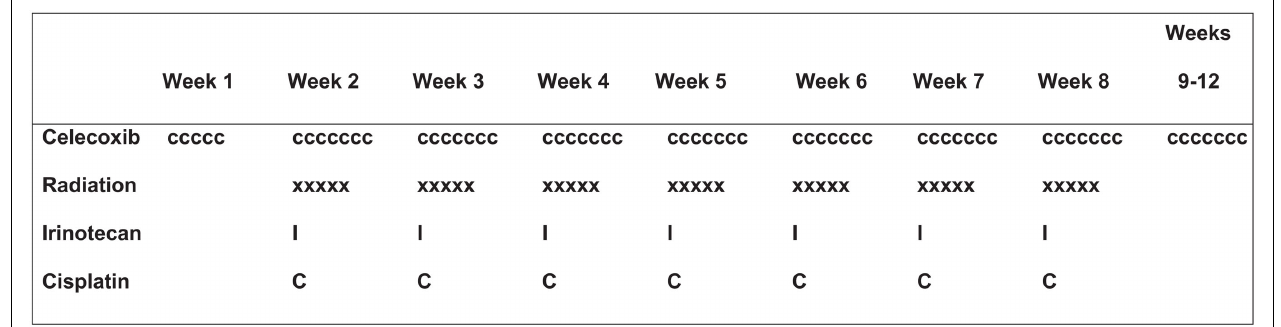
initiation of chemoradiation therapy; the same dose was continued daily throughout the entire 8-week course of chemoradiation therapy and for four more weeks thereafter (through week